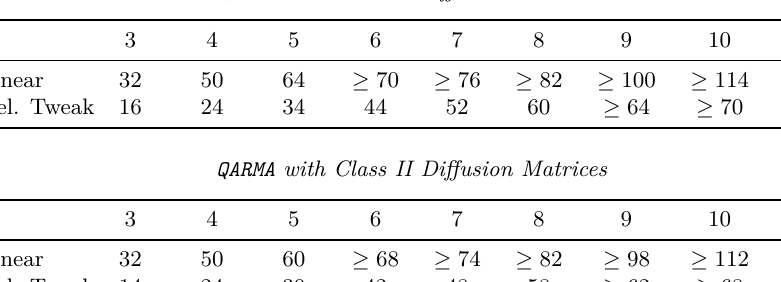
Table 3: Lower Bounds on the Number of Active S-Boxes QARMA with Class I Diffusion